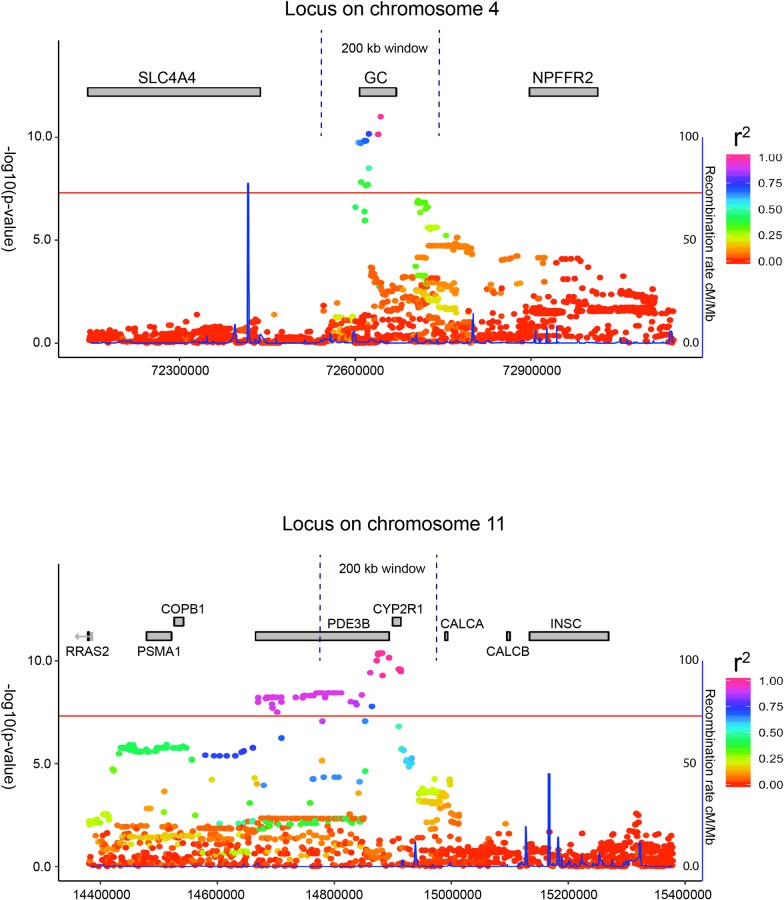
The two loci and their nearby genomic regions.A close up view of the genomic regions immediately surrounding the lead SNPs in each locus. The gene GC is the only gene within the 200 kb target window on chromosome 4, making it the likely candidate for the signal. For the locus on chromosome 11, both PDE3B and CYP2R1 are located within the window for likely candidates as the underlying cause of the signal.